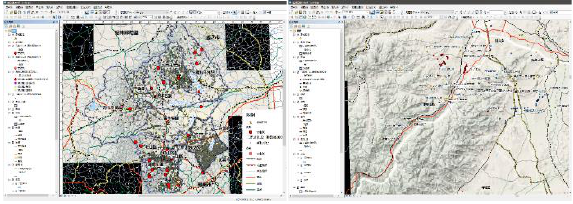
Figure 1. Making investigation plans by